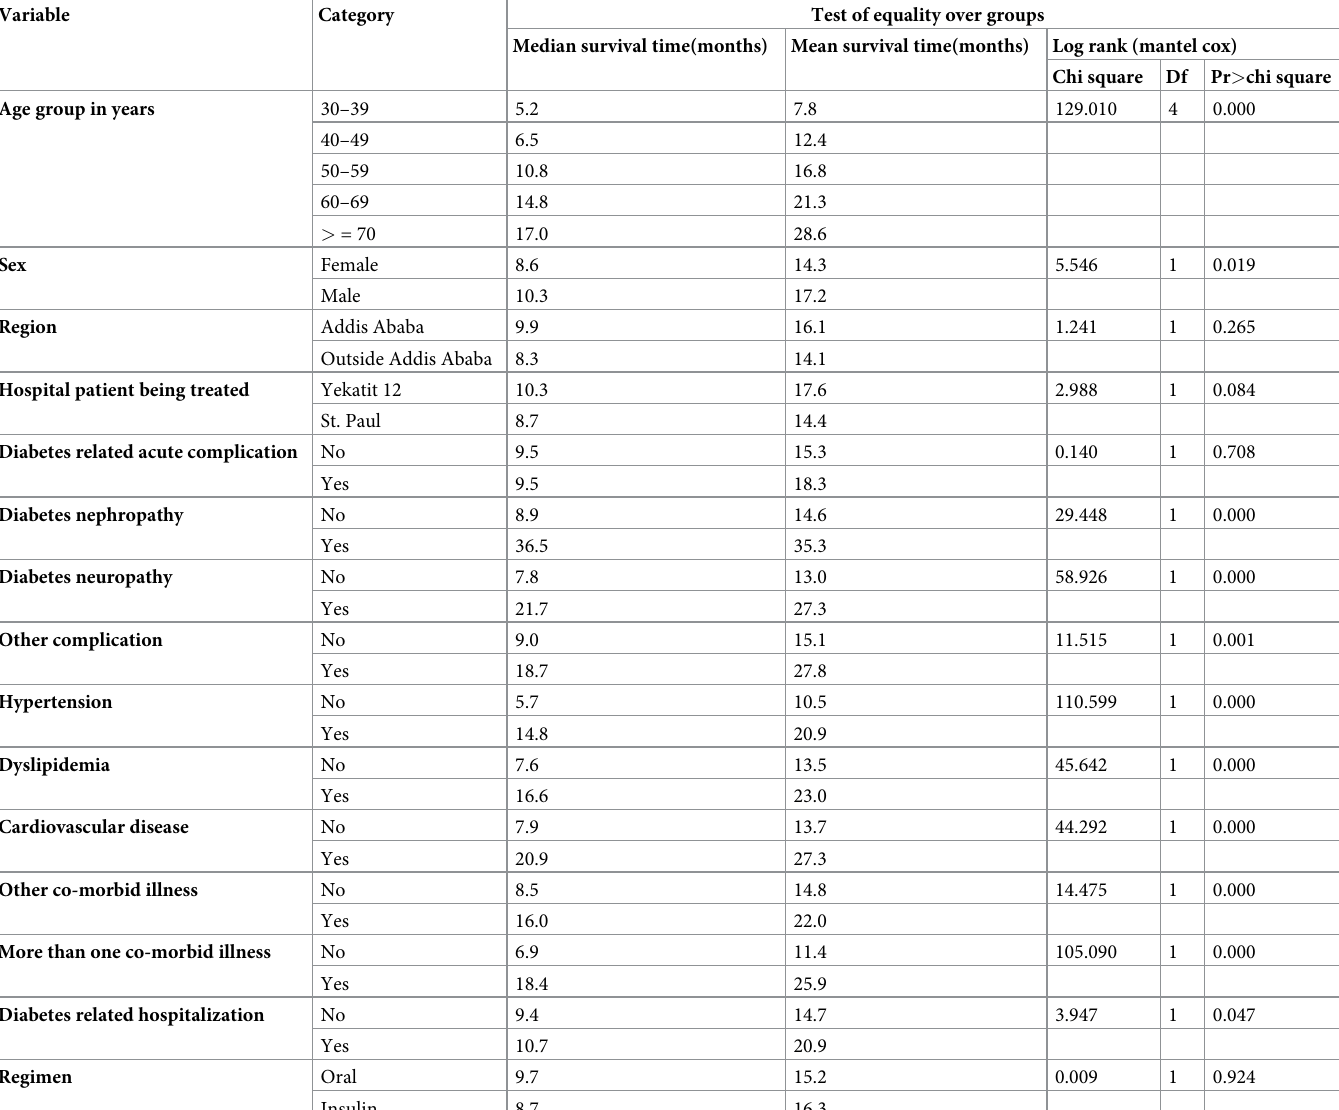
Table 4. Comparison of optimal glycaemic control among T2DM patients, Addis Ababa, 2018 (n = 685).